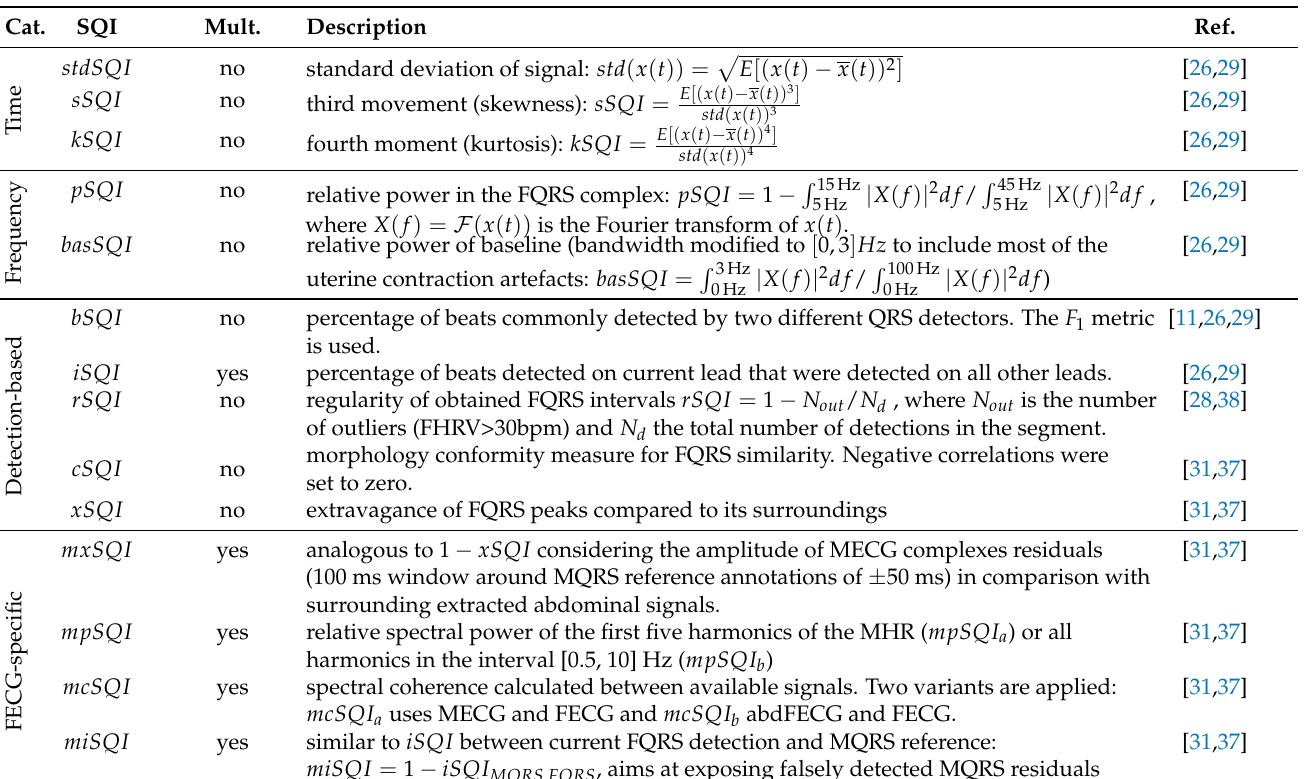
Table 1. Benchmark foetal SQI features [31,37].